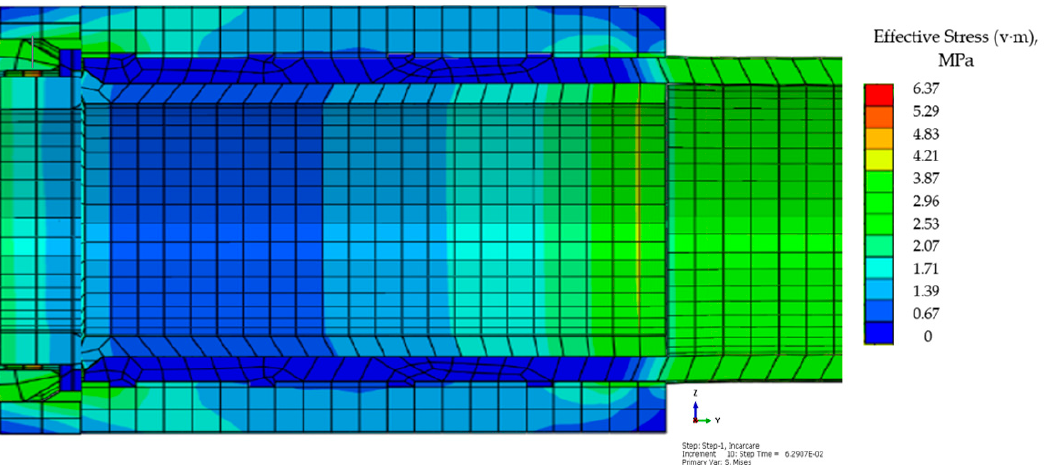
Figure 8. FEM analysis for TN fitting.